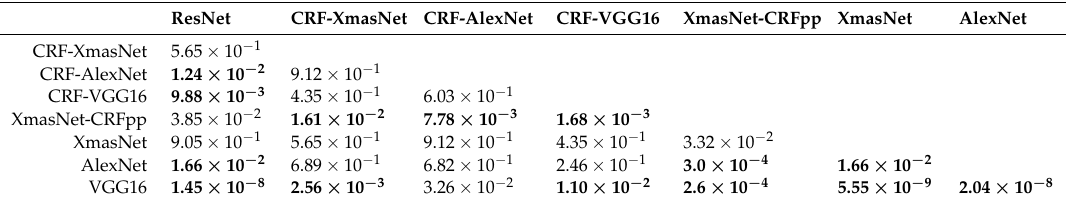
Table 7. P -values obtained from the statistical validation procedure. The Wilcoxon rank-sum test for pairwise data comparison was used with the alternative hypothesis that the samples do not have equal medians of AUROC (test set values). A significance level of α = 0.05 with a correction for multiple comparisons was used. Boldface indicates that the null hypothesis can be rejected.